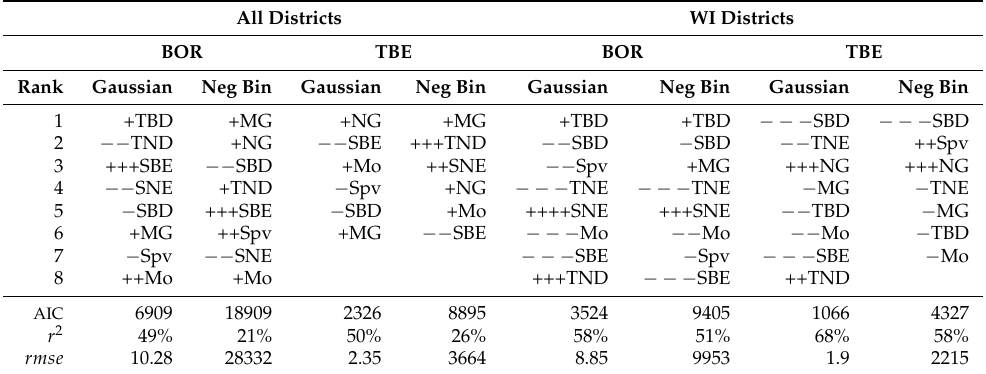
Table 2. Qualitative levels and signs of the coefficients for generalised linear regression models for BOR and TBE incidences with PFT fractional cover as explanatory variables; +++ indicates a high and positive coefficient, ++ indicates a less high coefficient, − − − indicates a high negative coefficient, etc. The acronyms for the PFTs are explained in Table